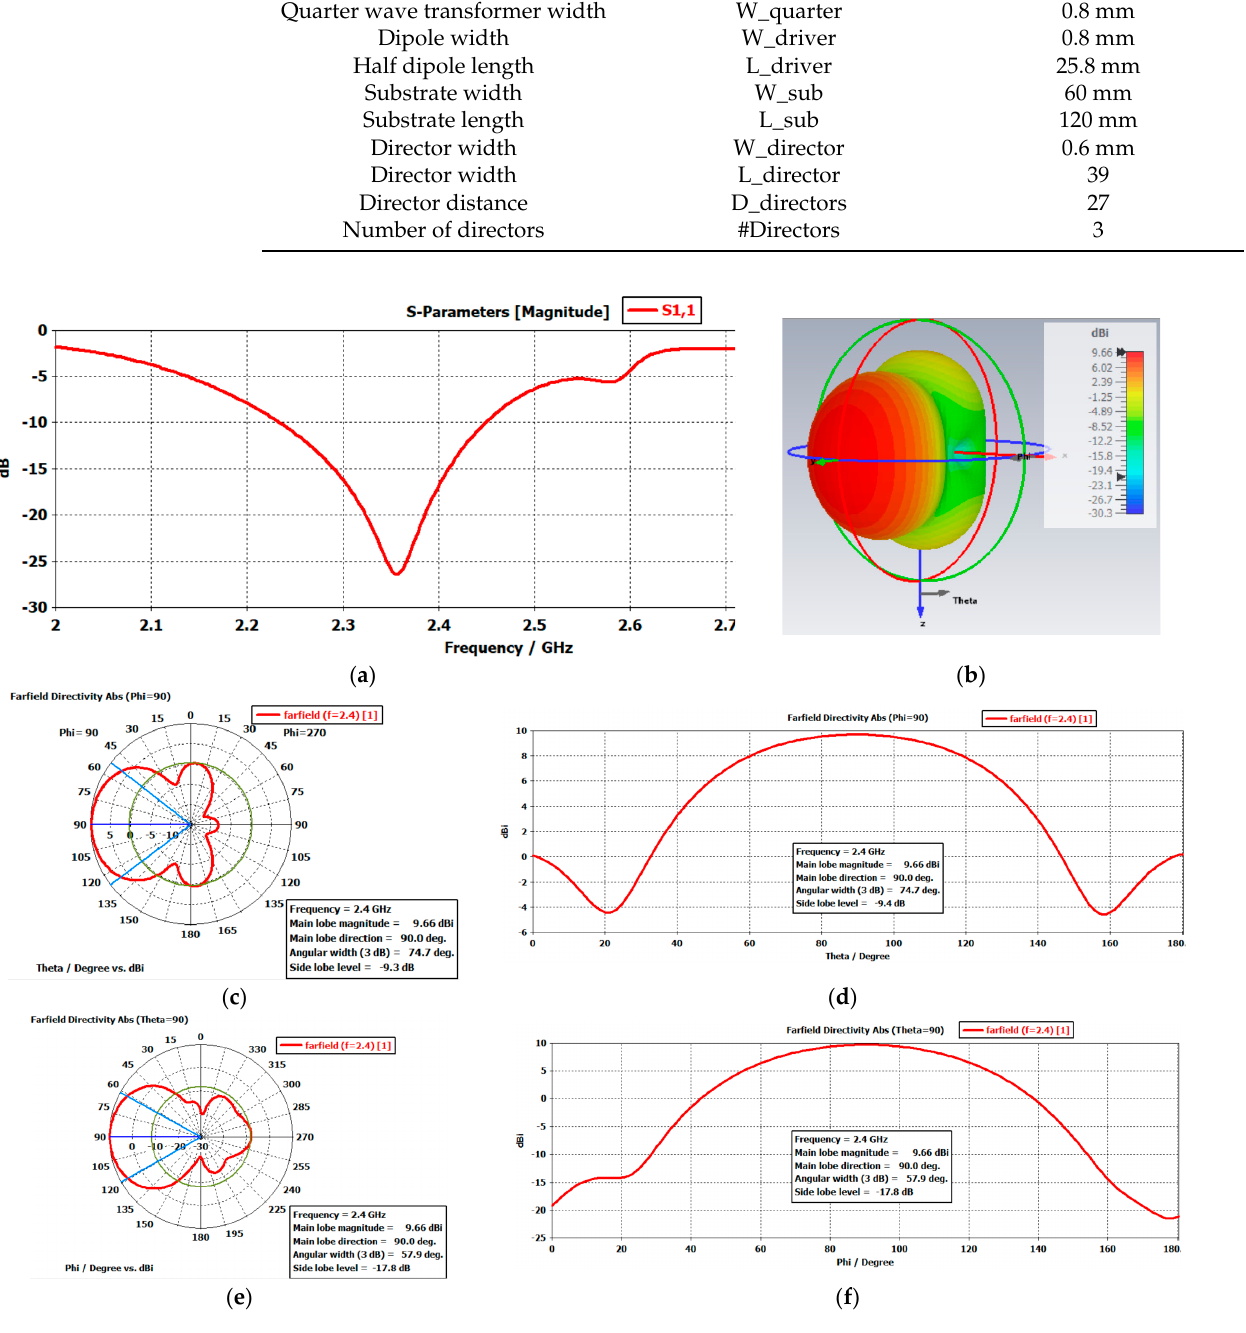
Figure 6. ( a ) Return Loss; ( b ) Farfield plot of the Yagi–Uda antenna; ( c ) Elevation Farfield directivity (polar view); ( d ) Elevation Farfield directivity (cartesian view); ( e ) Azimuth Farfield directivity (polar view); ( f ) Azimuth Farfield directivity (cartesian view).